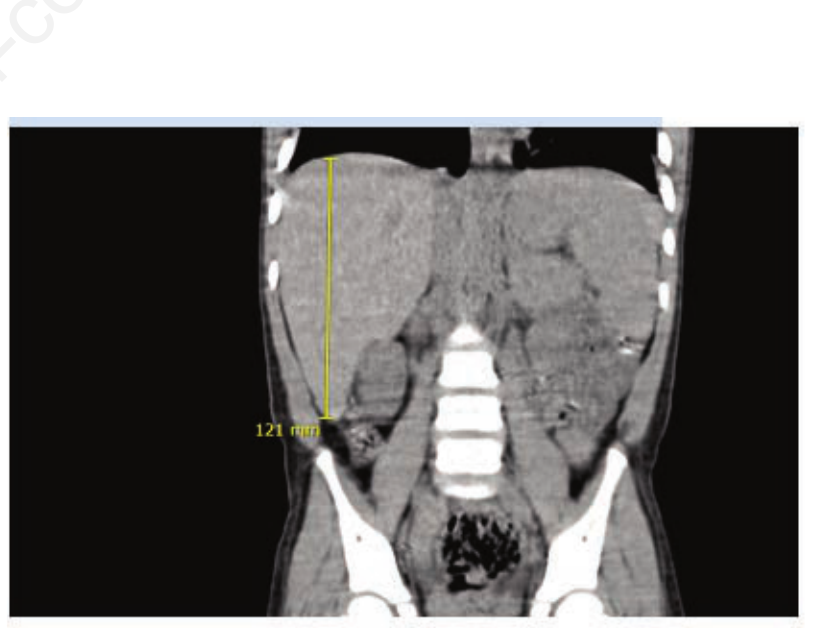
Figure 2. Computed tomography of the abdomen. Liver longitudinal